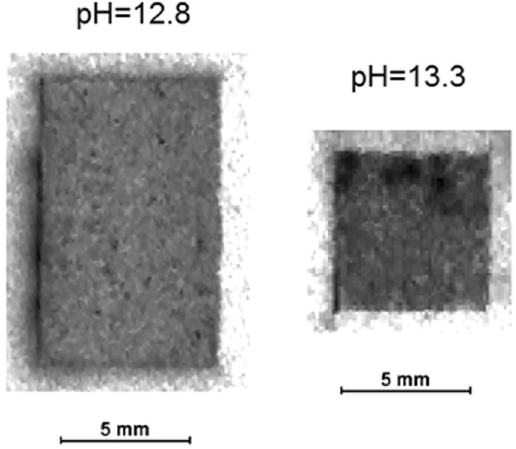
Figure 3. Autoradiography imaging of the PbS ( 228 Th) sample grown on GaAs (100) at pH 12.8 and pH 13.3.